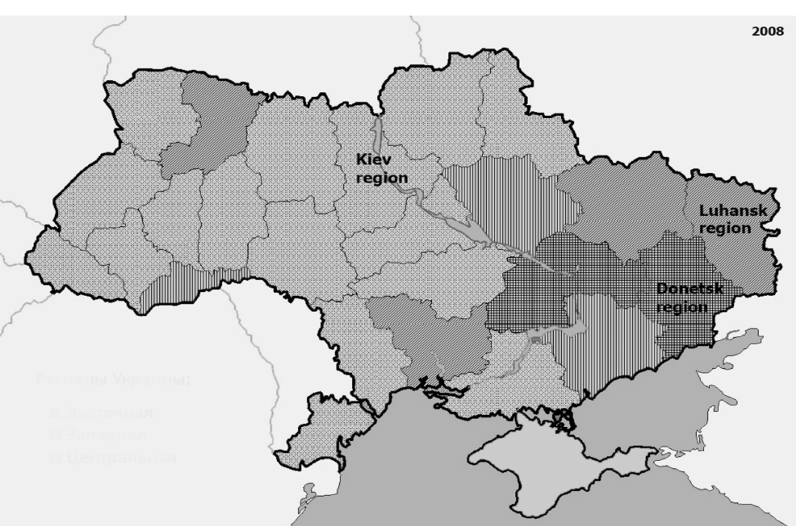
Figure 6. Mapping sustainable development of regions in Ukraine according to their affiliation to the attributive groups in